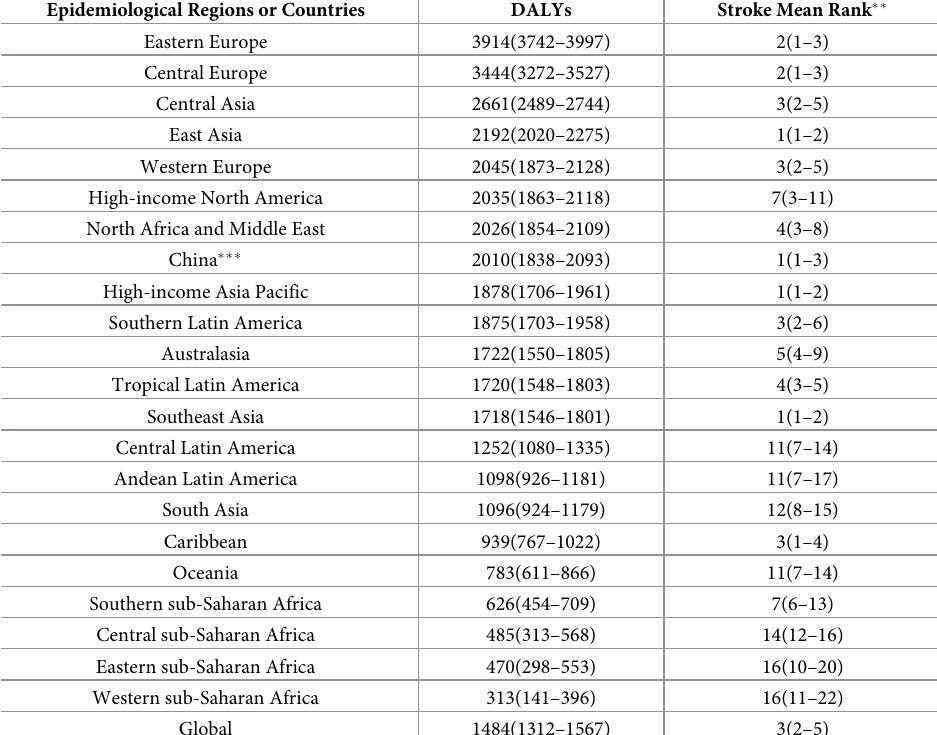
Table 3. DALYs per 100000 caused by stroke and stroke Mean Rank (95%UI) among the 21 GBD epidemiological regions [15] and China � . Epidemiological Regions or Countries DALYs Stroke Mean Rank